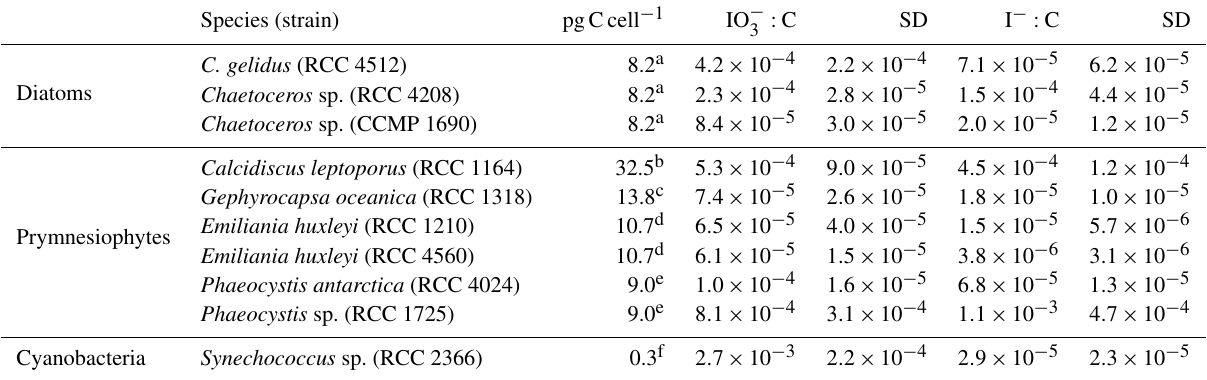
Figure 4. Total cell counts (black – total) and fluorescence readings (green) as well as inorganic iodine speciation (red – iodate, yellow – iodide) over the course of the growth curve experiments of prymnesiophytes for Phaeocystis antarctica (RCC 4024) in (a) and (b) and Phaeocystis sp. (RCC 1725) in (c) and (d) . The colour-shaded bars on top of each graph indicate where the logarithmic phase (green), the stationary phase (yellow) and the senescent phase (red) began and ended based on total cell counts. Values depicted are means from culture replicates, with error bars indicating the standard deviations of these means. Table 3. Ratios of IO − removal and I − production to increase in cellular carbon (net primary production – NPP). Also presented are the 3 cellular carbon levels used to make these calculations. Errors are the standard deviations of three replicate